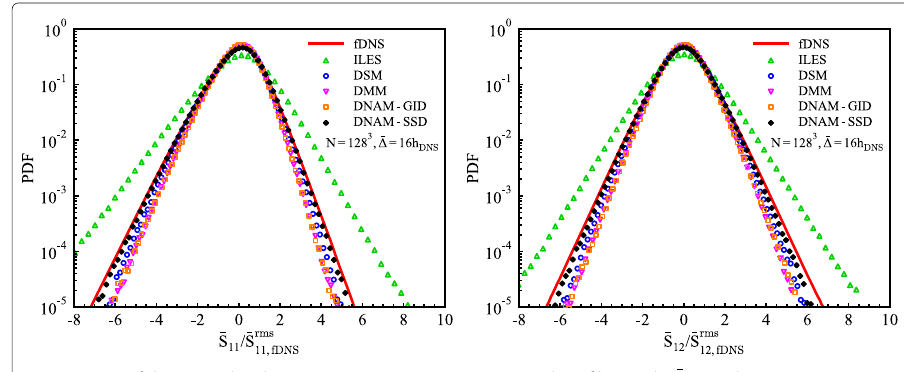
Fig. 8 PDFs of the normalized strain-rate tensor in aposteriori study at filter scale 16 h DNS